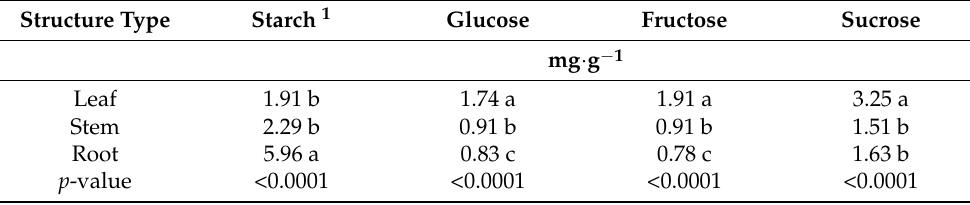
Table 6. Distribution of carbohydrates in Encore ® azalea ‘Chiffon’ among leaves, stems and